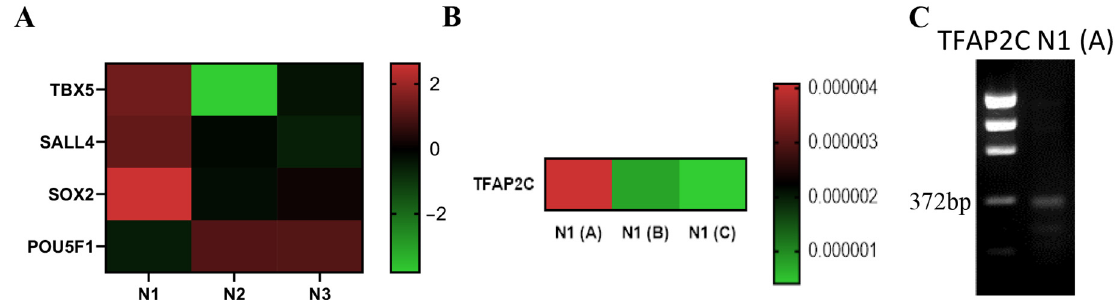
Figure 5. TFAP2C reveals a subpopulation of Isl-1, SALL4, TBX5, EPCAM, SOX2 expressing neonatal CPC clones. Heatmap visualization generated from Isl-1+ neonatal RNA-Seq data showing differentially expressed genes in Neonate 1, Neonate 2 and Neonate 3 CPC clones ( A ). Heatmap visualization of RT-PCR analysis of TFAP2C mRNA levels in three neonatal CPC clones derived from 8-day old patients. These clones are represented as Neonate 1 (N1A), Neonate 1 (N1B) and Neonate 1 (N1C). RT-PCR was performed on cDNA using gene specific primers ( B ). Gel image of TFAP2C (372 bp) mRNA expression in N1 ( A ) Isl-1+ neonatal CPC clone expression as detected by RT-PCR ( C ).